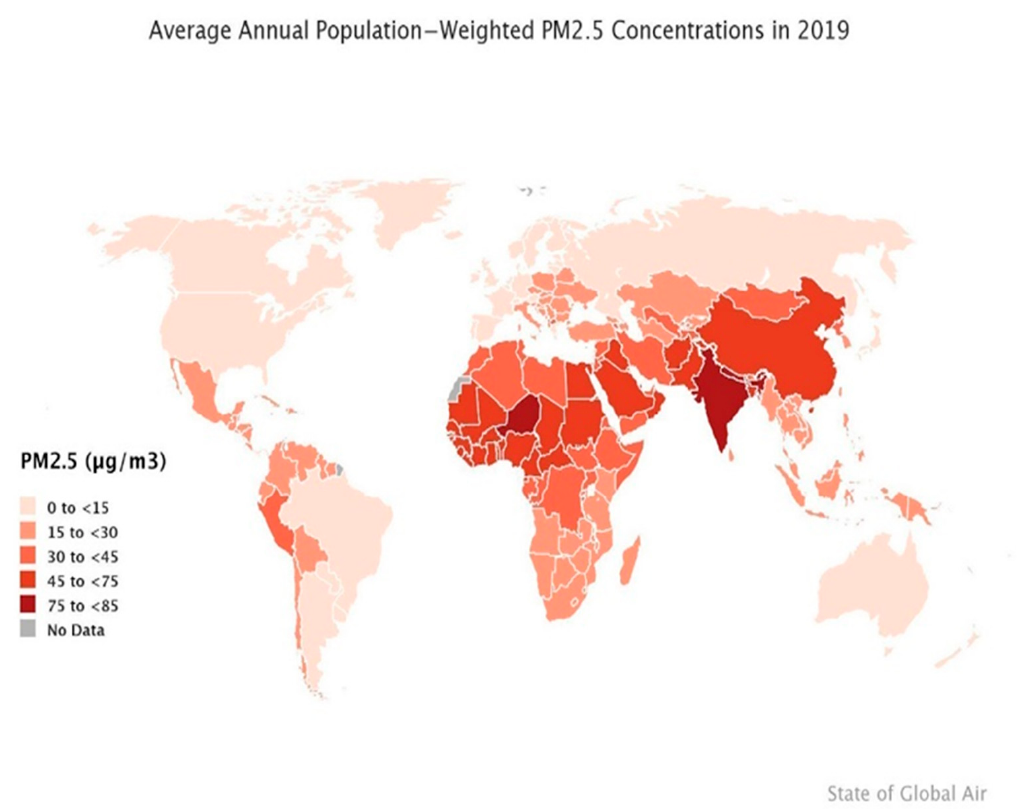
Figure 2. The levels of PM 2.5 worldwide [Source: Health Effects Institute (2020)]. State of Global Air (2020). PM 2.5 Exposure, State of Global Air (2020). Retrieved 28 November 2021, from https://www.stateofglobalair.org/air/pm [50]. (Permission was granted to use this figure on July 13th, 2022 by the Health Effects Institute staff).